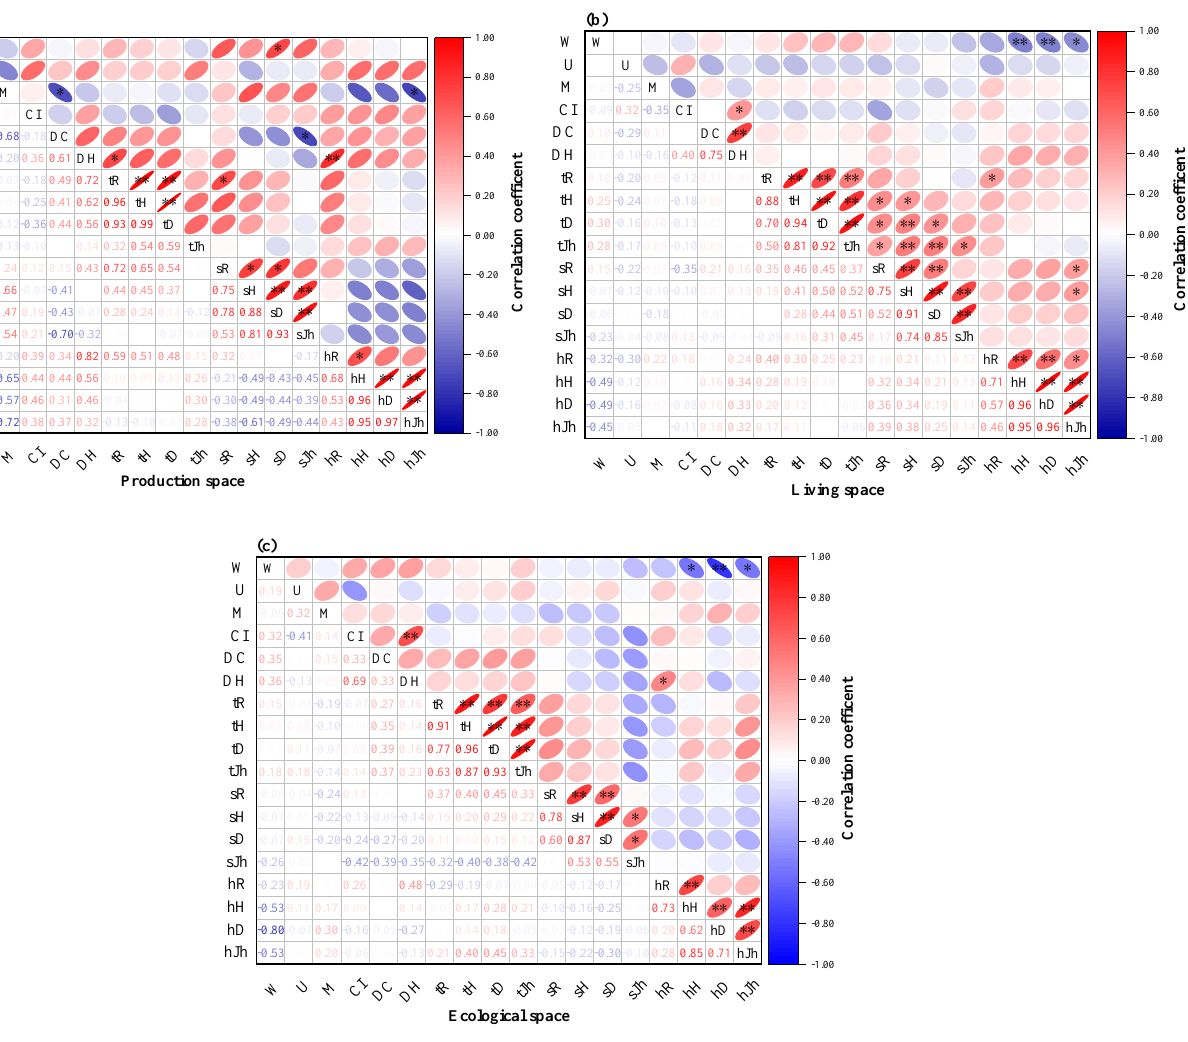
* p<=0.05 ** p<=0.01 Figure 7. Relationship between plant community structure and species diversity in different altitude gradients. ( a ) Production space; ( b ) living space; and ( c ) ecological space.